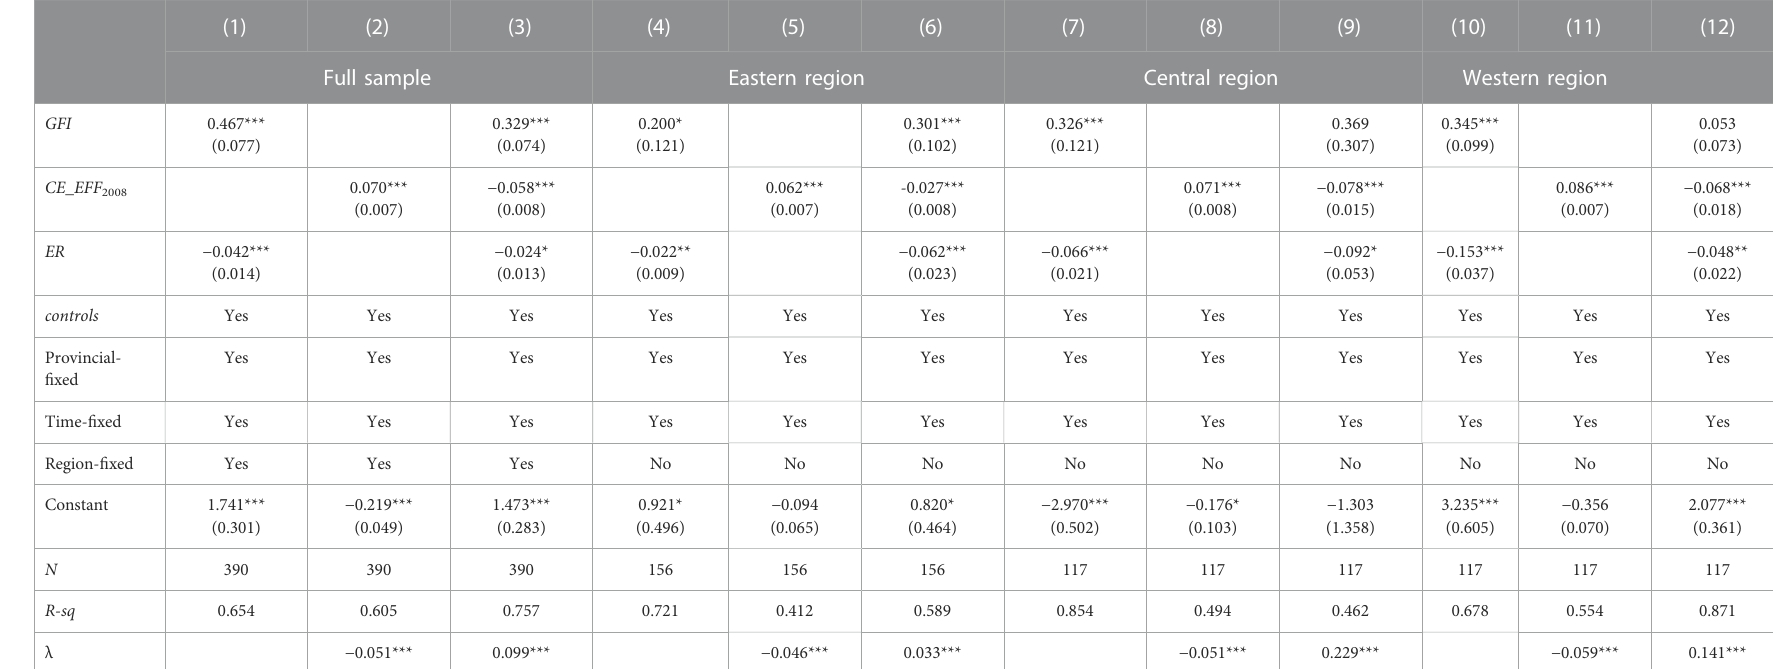
TABLE 4 Results of the robustness